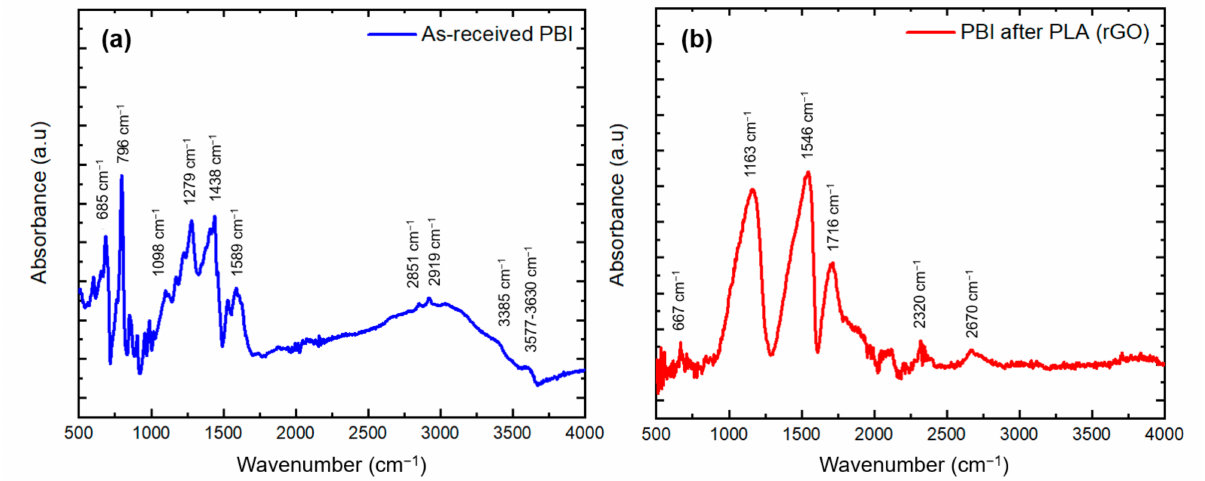
Figure 10. FTIR spectra of ( a ) non-processed PBI and ( b ) rGO after laser processing of